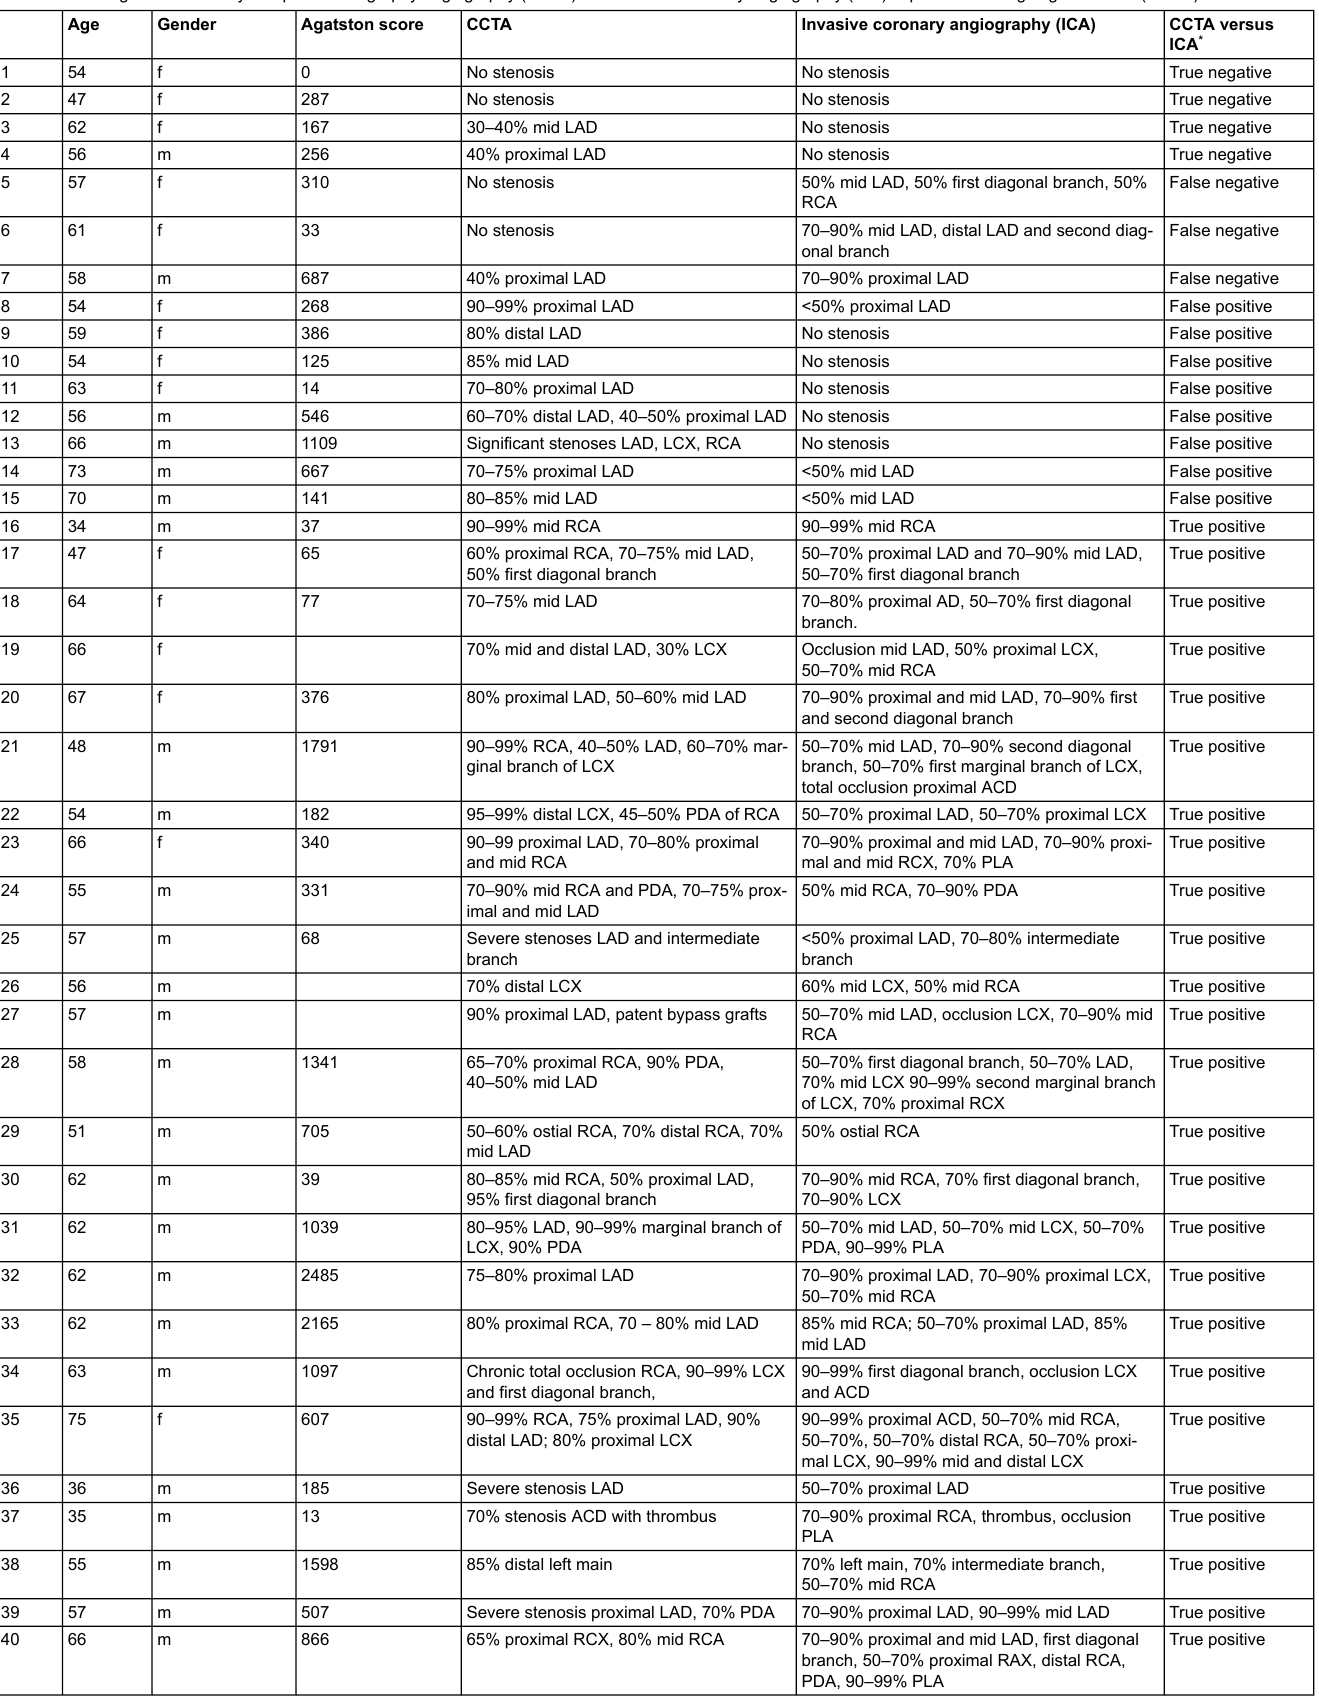
Table S1: Findings from coronary computed tomography angiography (CCTA) and invasive coronary angiography (ICA) in patients undergoing both tests (n = 59) Age Gender Agatston score